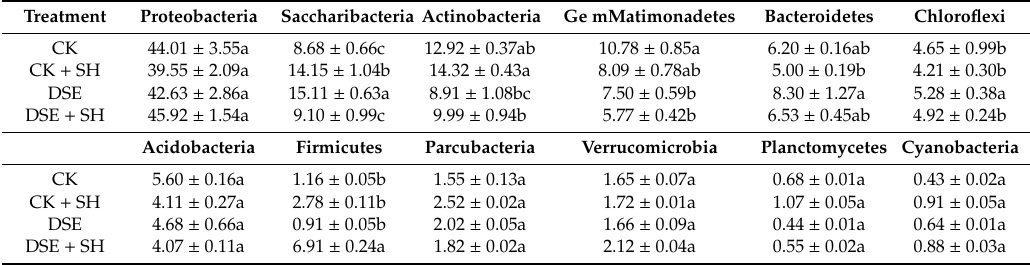
Table 5. The relative abundance of the main phylum in CK, CK + SH, DSE, DSE + SH treatments.